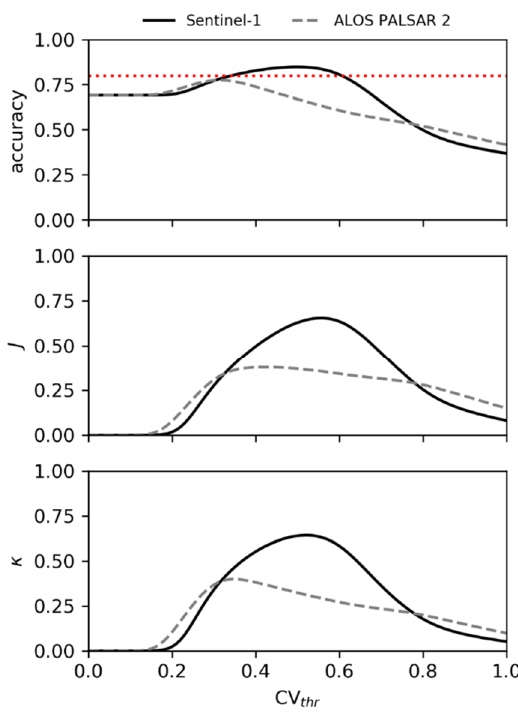
Figure 5. Plot of the three performance metrics (Accuracy, J-statistic and Cohen’s Kappa) versus the crop/non-crop delineating threshold for Sentinel-1 (solid) and PALSAR-2 (dashed). The horizontal dashed line indicates an accuracy threshold of 80%.